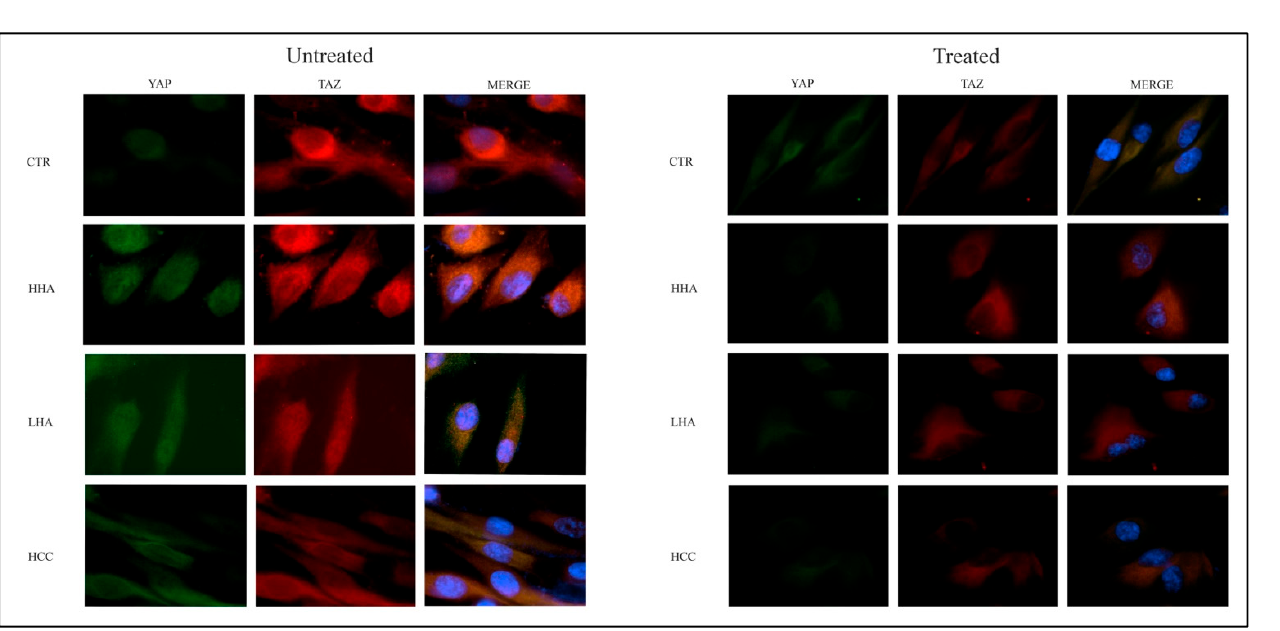
Figure 7. Analysis of YAP and TAZ, expression at 72 h by immunofluorescence in standard medium after YAP/TAZ inhibitor-1 treatment. The expression of YAP and TAZ was clearly evident both at cytoplasmic and nuclear level in untreated cells; after YAP/TAZ inhibitor-1 treatment, YAP and TAZ expression was strongly reduced, and the localization was predominantly in cytoplasm. Original magnification: 100×.